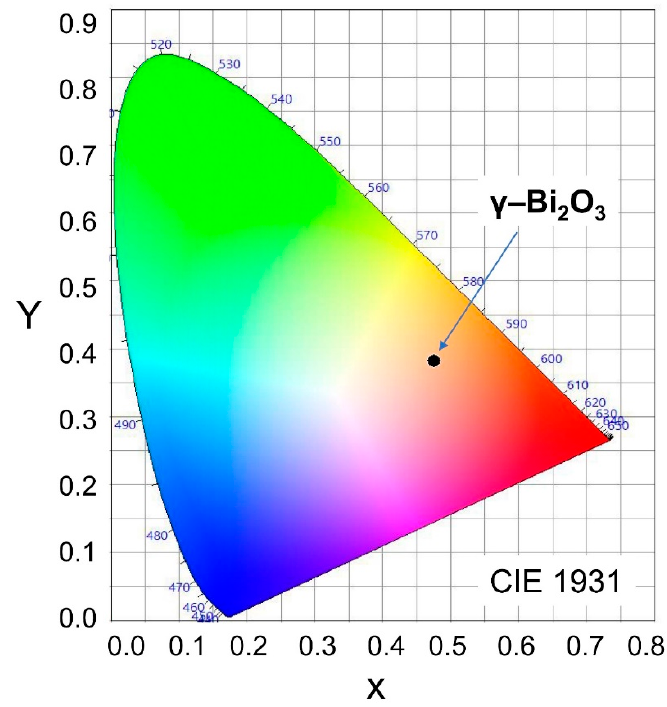
Figure 5. CIE 1931 color space chromaticity diagram in the ( x , y ) coordinates system showing orange color (black dot) of the PL emission from γ –Bi 2 O 3 NPs.